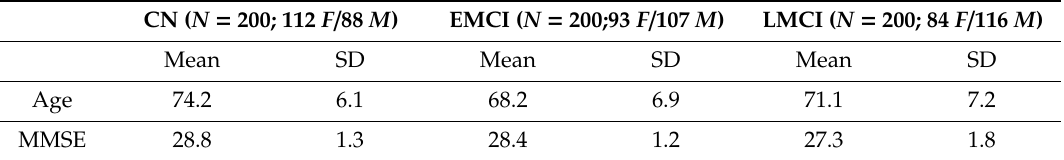
Table 1. The subjects’ clinical and demographic characteristics. For each group, N represents the total number of subjects, M and F show number of males and females, along with the average age, standard deviation (SD) and average mini-mental state examination (MMSE)